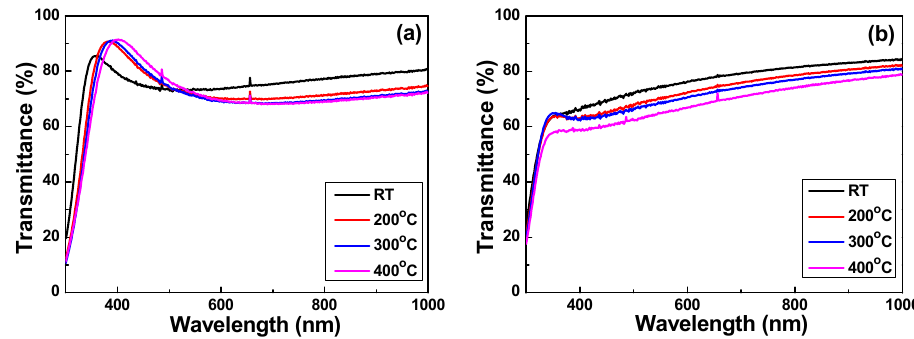
Figure 3. Measured transmittance of Nb 2 O 5 thin films as a function of deposition temperature and O 2 ratio. ( a ) O 2 ratio 10% and ( b ) O 2 ratio 20%, respectively. Table 2. Average total transmittances, maximum transmittance ratio, and light wavelength of maximum transmittance ratio of Nb 2 O 5 thin films.